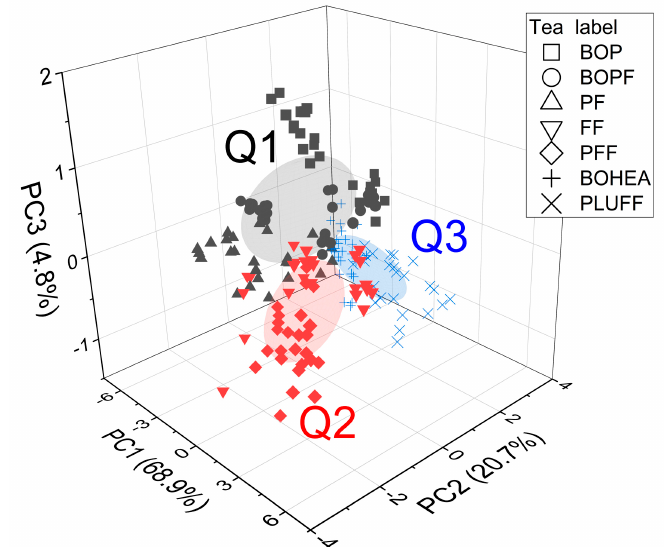
Figure 3. PCA 3D plots with confident level 50% regarding the unsupervised classification of tea samples from different brands (BOHEA, BOP, BOPF, FF, PF and PLUFF as listed in Table 1) according to their quality grades (Q1, Q2 and Q3) based on the E-nose profiles after signal preprocessing data treatment using F 1 procedure.